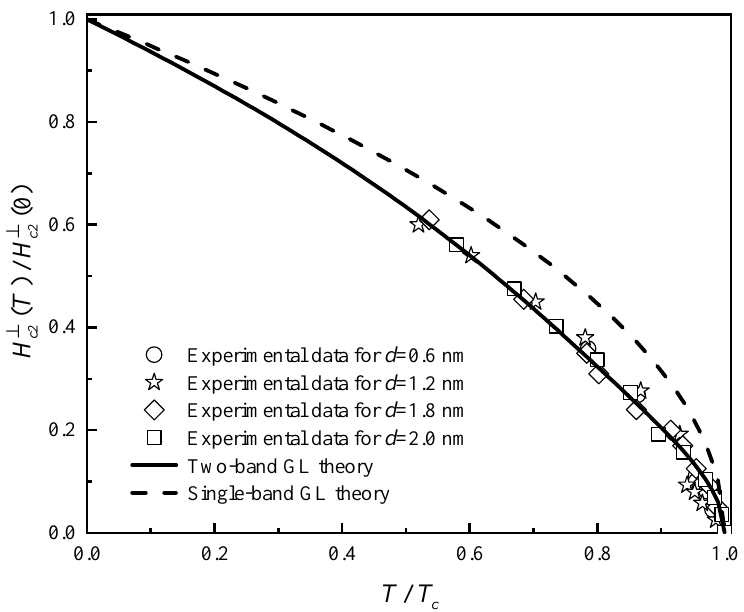
Figure 2. The temperature dependence of normalized upper critical magnetic field perpendicular to the c -axis for the NbSe 2 thin film. The experimental data of the NbSe 2 with the thickness d = 0.6, 1.2, 1.8, and 2.0 nm are taken from Ref.